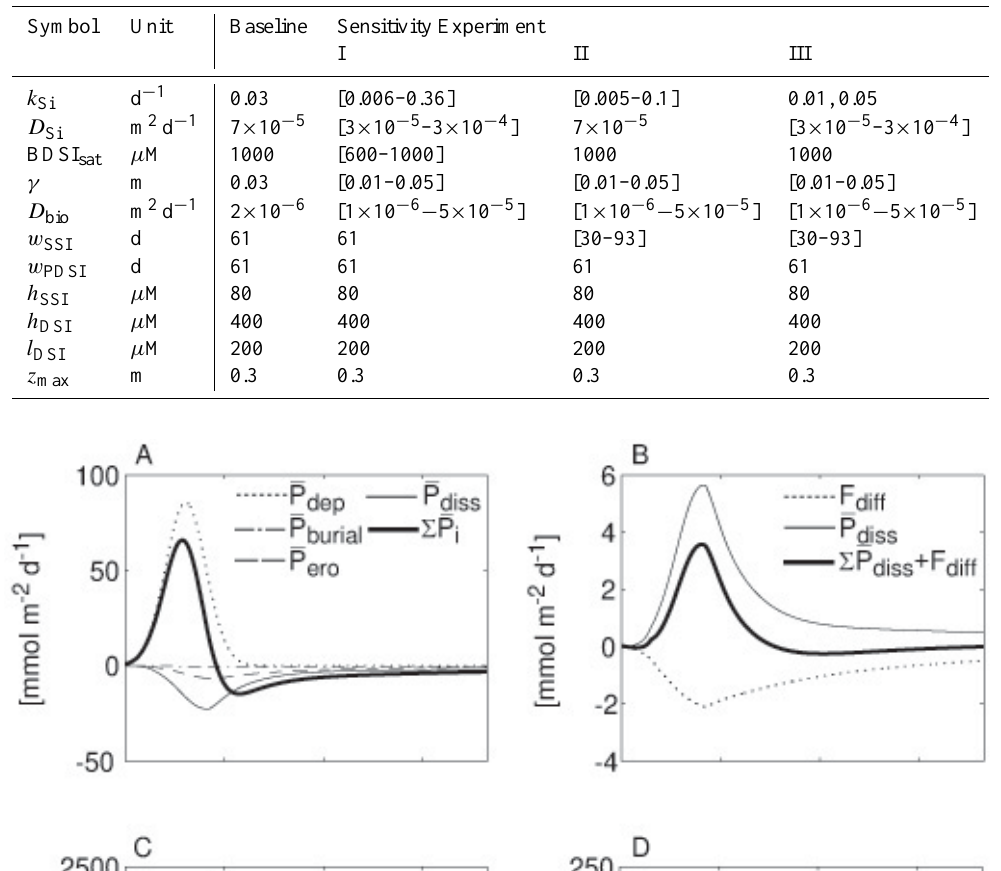
Table 2. Parameter sets used in model simulations.